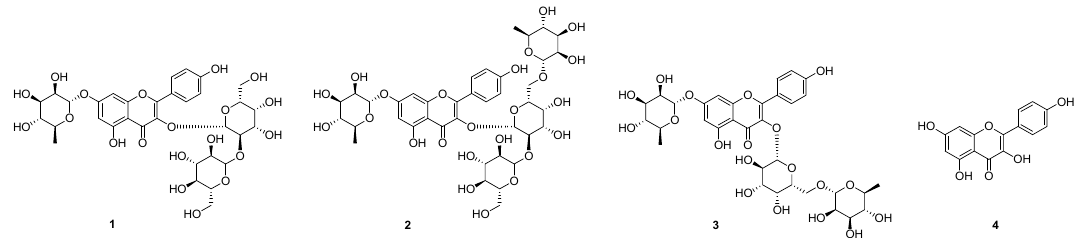
Figure 1. Chemical structures of compounds 1 – 3 isolated from the seeds of Lens culinaris and kaempferol ( 4 ).